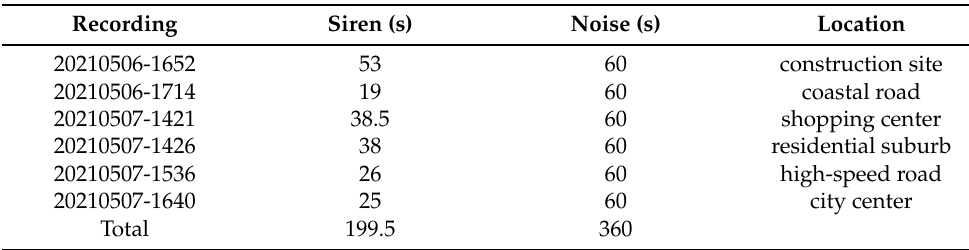
Figure 5. A3S-Rec positive and negative audio data selection method. Table 1. A3S-Rec audio file composition and recording